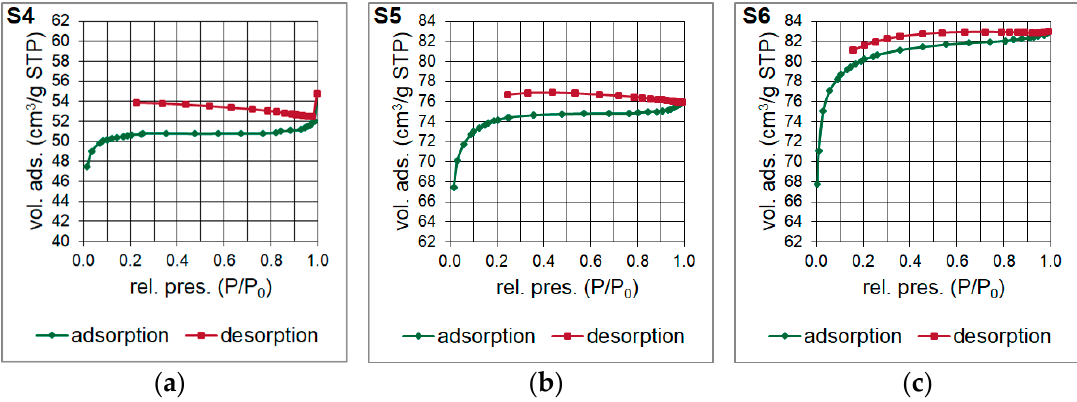
Figure 5. ( a – c ) Nitrogen adsorption-desorption isotherms of the silicon oxycarbide materials (S4–S6 samples), abbreviations: vol. ads.—volume adsorbed, rel. pres.—relative pressure.